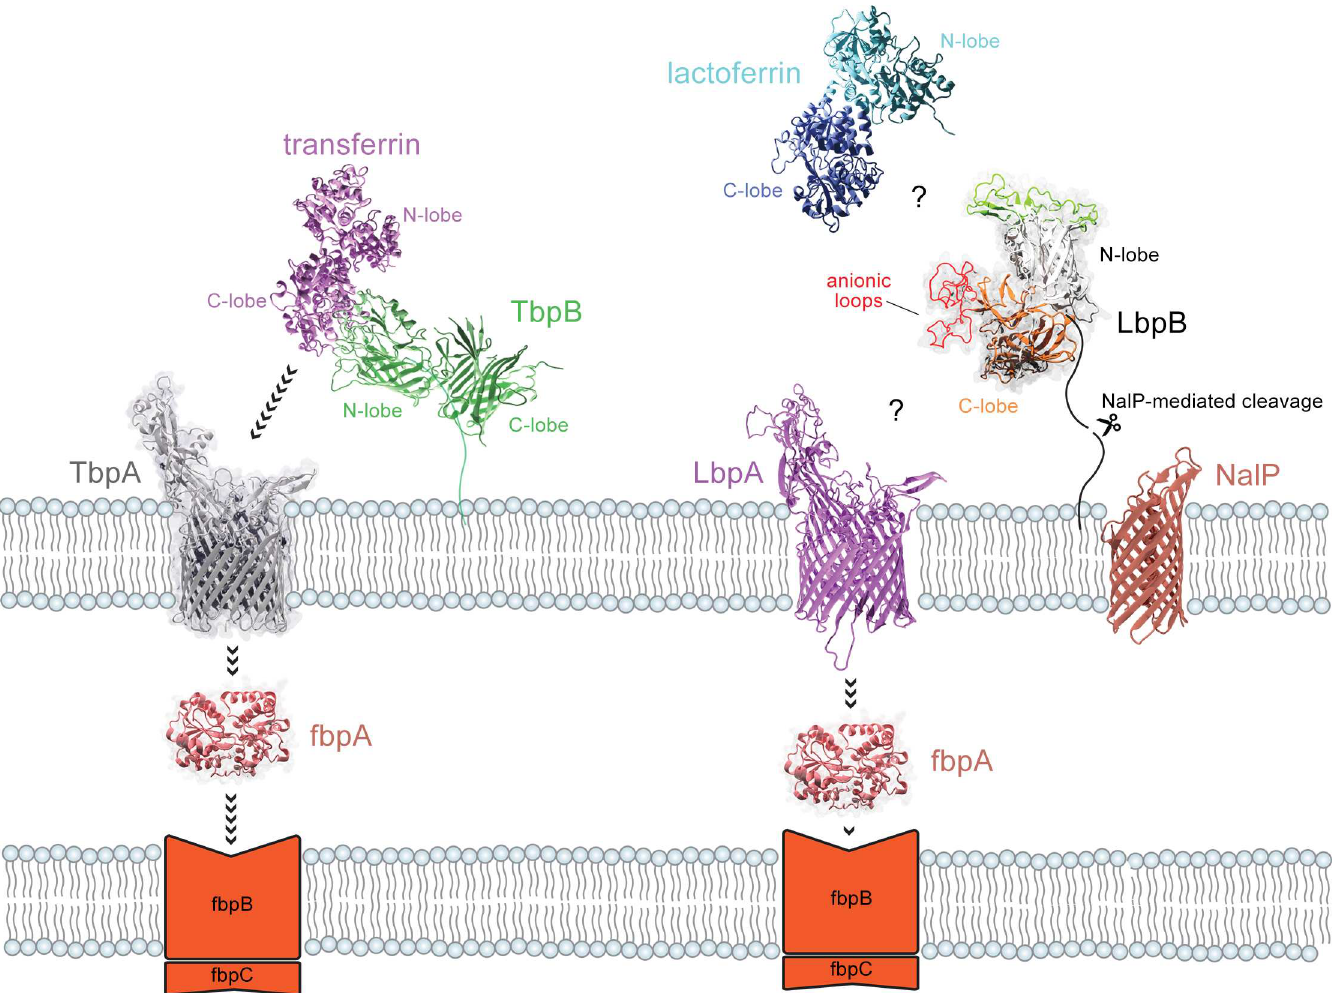
Fig 1. Model for iron acquisition from hTf and hLf. TbpB N-lobe captures iron-loaded hTf by bindingto the C-lobeand transferringit to TbpA. TbpA extracts iron from hTf and transports it across the outer membranewhere it is bound by FbpA and subsequently transportedinto the cytoplasm by the FbpBC inner membranecomplex. It remainsunclear whetherhLf directly binds LbpA or is it first boundby LbpB, analogousto the TbpBA receptor or whether cleavageby NalP wouldcompromisethe role of LbpB in iron transport.